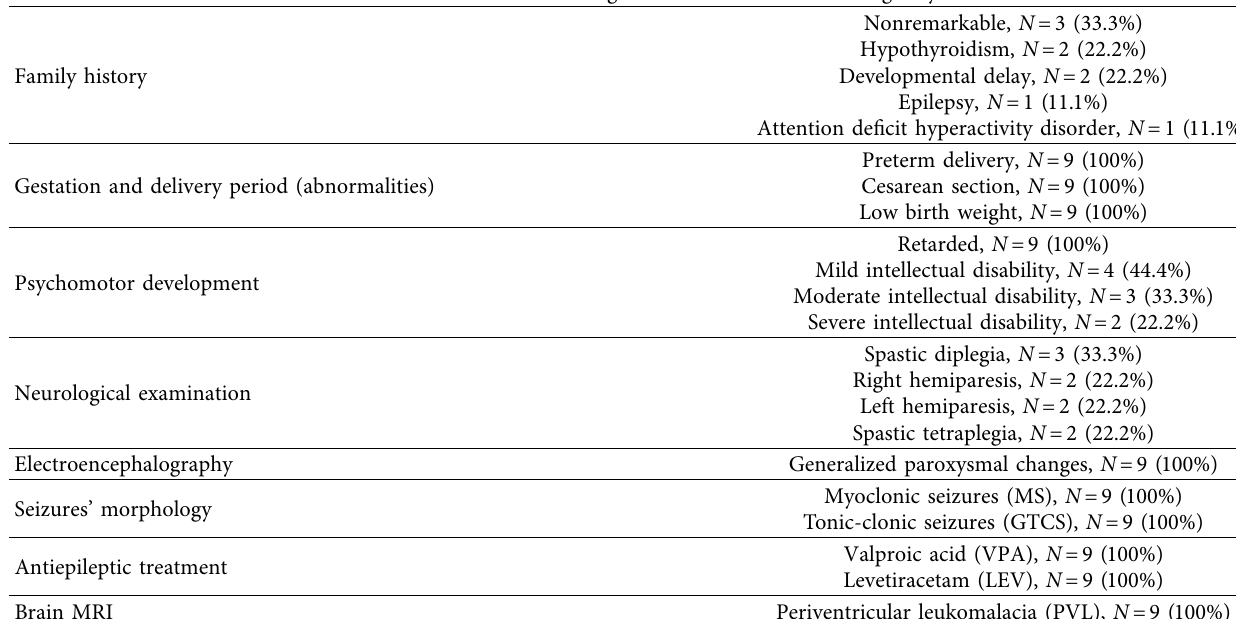
Table 1: Patients’ characteristics: age 65–80 months and mean age 6